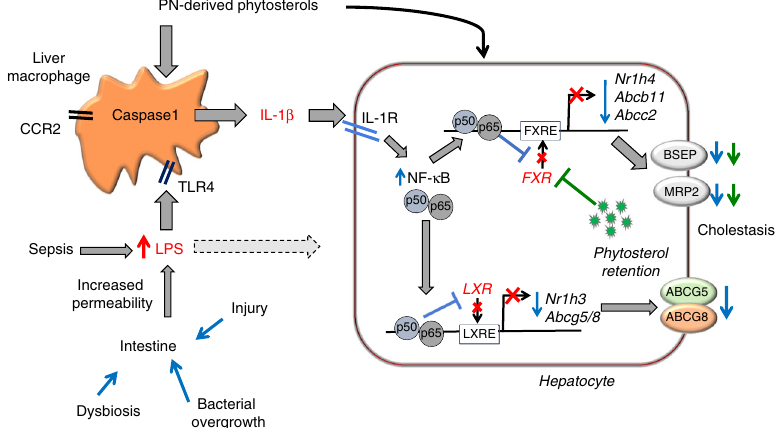
Fig. 6 Hypothetical model of PNAC pathogenesis. Increased intestinal permeability secondary to intestinal in fl ammation and dysbiosis promotes increased absorption of LPS into portal vein with subsequent TLR4-mediated activation 25 and caspase-1- dependent generation of IL-1 β in recruited CCR2 + macrophages (phytosterols contribute to macrophage activation and IL-1 β synthesis) 26 . Through IL-1 receptor (IL-1R) binding on hepatocytes, IL-1 β subsequently activates NF- κ B in hepatocytes, which interferes with the ability of LXR and FXR to bind to promoters (red crosses) and activate expression of ABCG5/8 , ABCB11 , and ABCC2 , resulting in decreased expression of BSEP, MRP2, and ABCG5/8 (blue downward arrows) and phytosterol retention (green dots). Retained phytosterols antagonize FXR activity leading to additional reduction in BSEP and MRP2 expression and subsequent retention of bile acids and bilirubin (additional phytosterol effects indicated by green downward arrows) and cholestasis. In addition, direct effects of LPS on the hepatocyte can suppress FXR activity (dotted line from LPS to